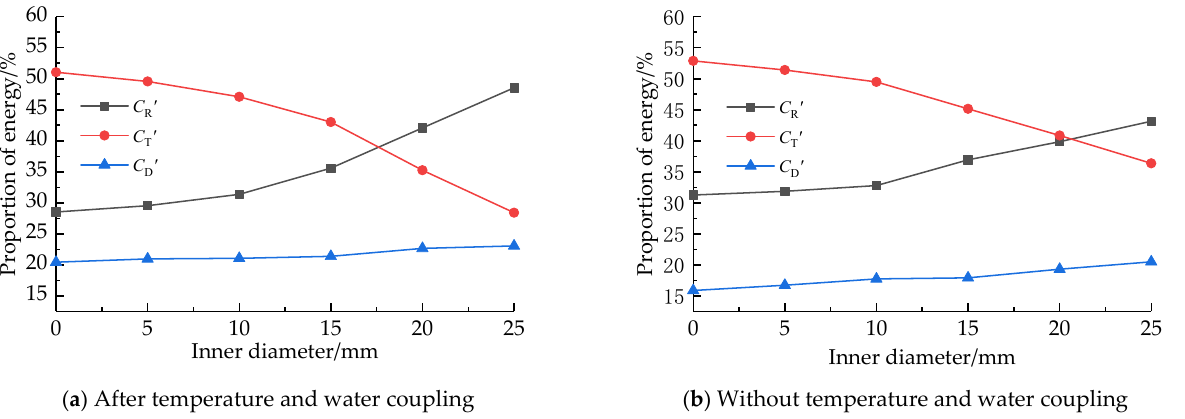
Figure 16. Energy proportion